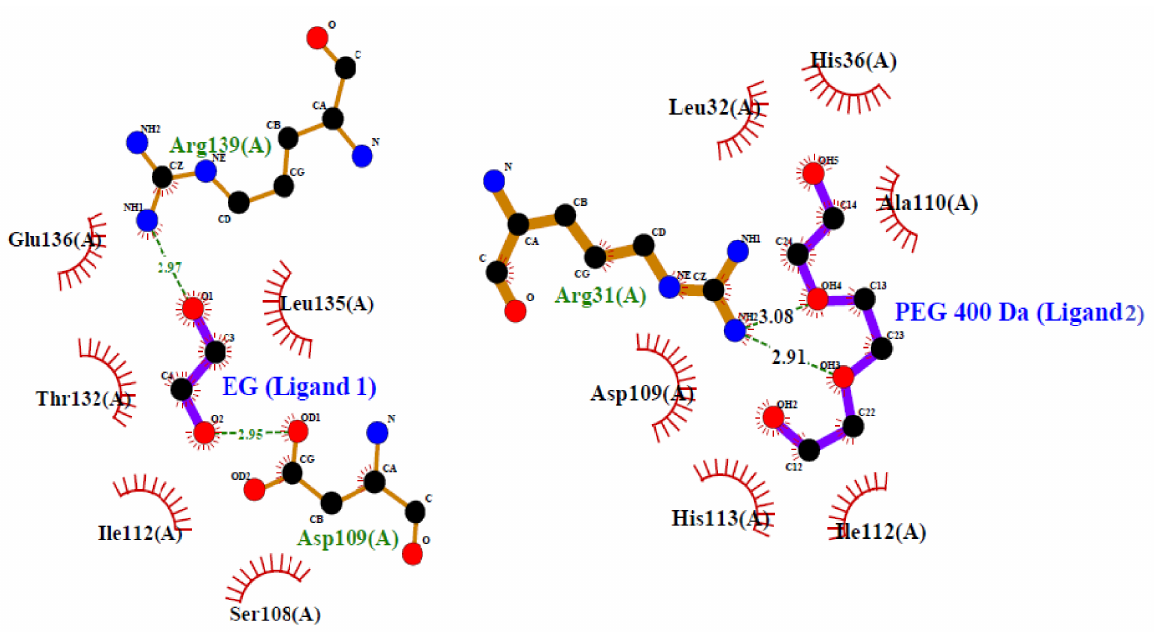
Figure 5. 2D-representation of various types of interactions between amino acid residues of Mb with crowders (PEG 400 and EG) using